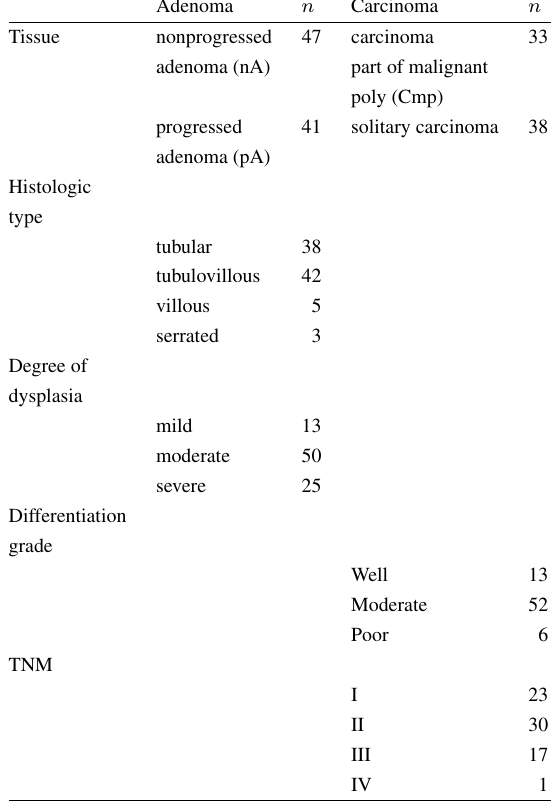
Histological characterics of 159 adenomas and carcinomas